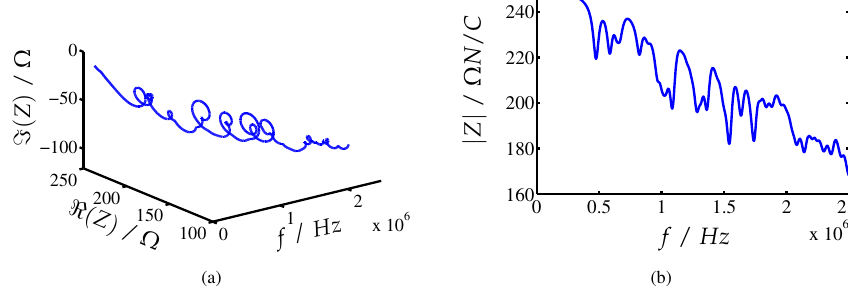
Figure 3. (a) Complex impedance vs. frequency; (b) magnitude of impedance vs. frequency.